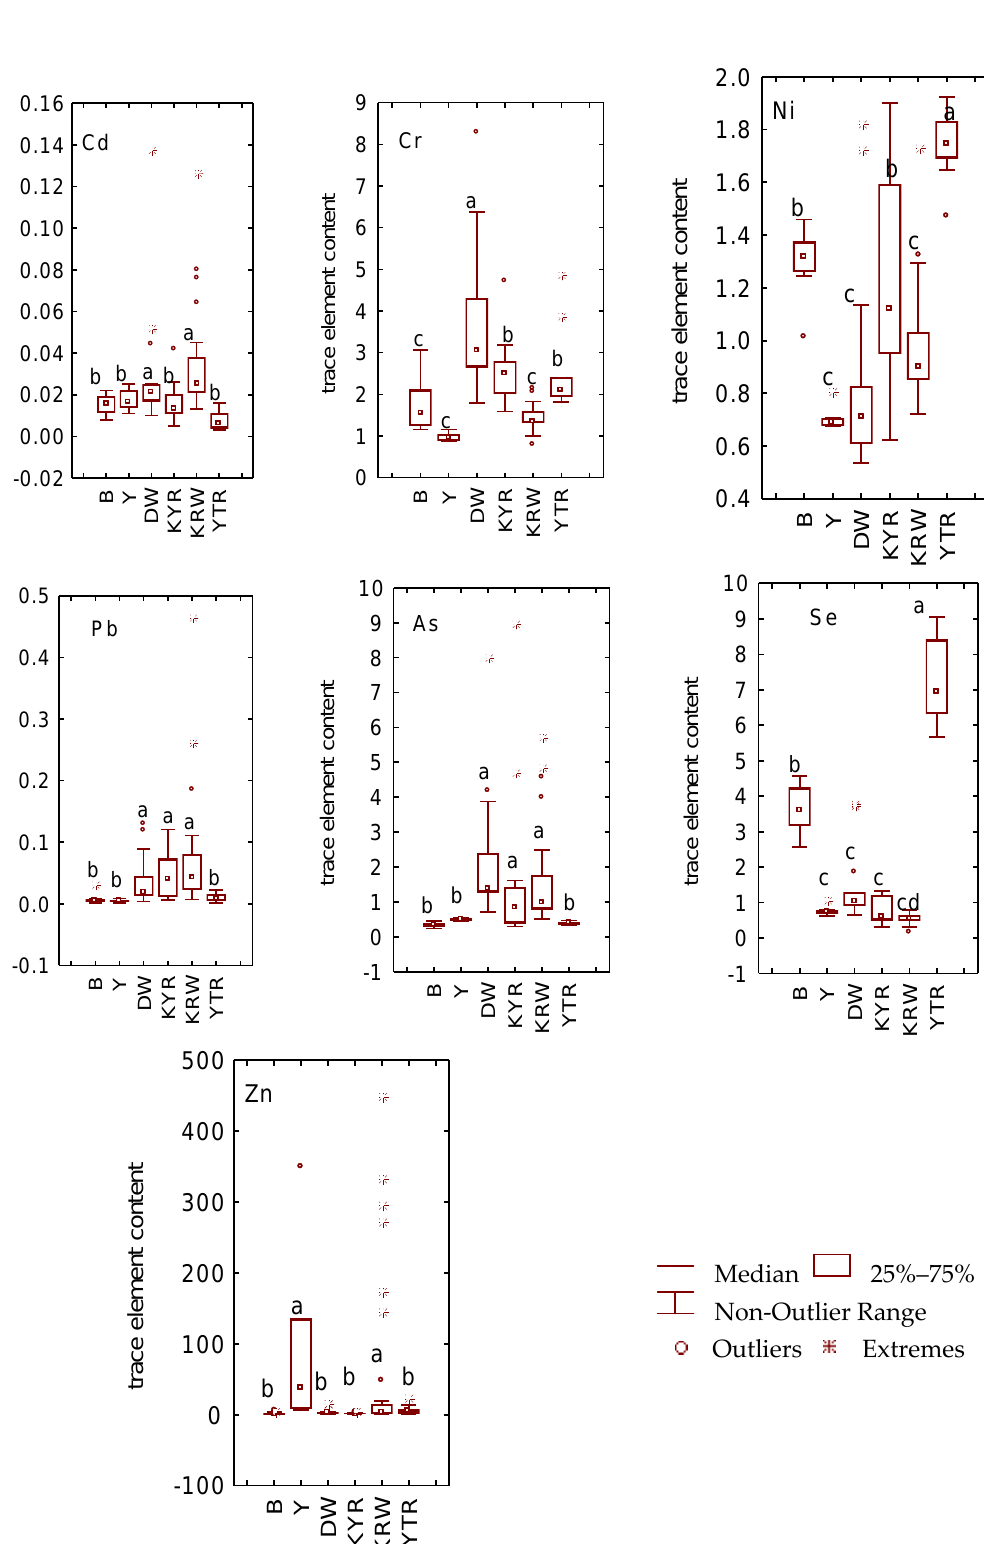
Figure 2. The trace element concentrations in the drinking water of Bay County. Boxes with different letters were significantly different at p < 0.05. Significance was determined by nonparametric comparison (Kruskal-Wallis test. DW: Dawanqi; KYR: Keyiri; KRW: Kriwahi; Y: Yangchang; YT: Yaturi; B: Bulong.